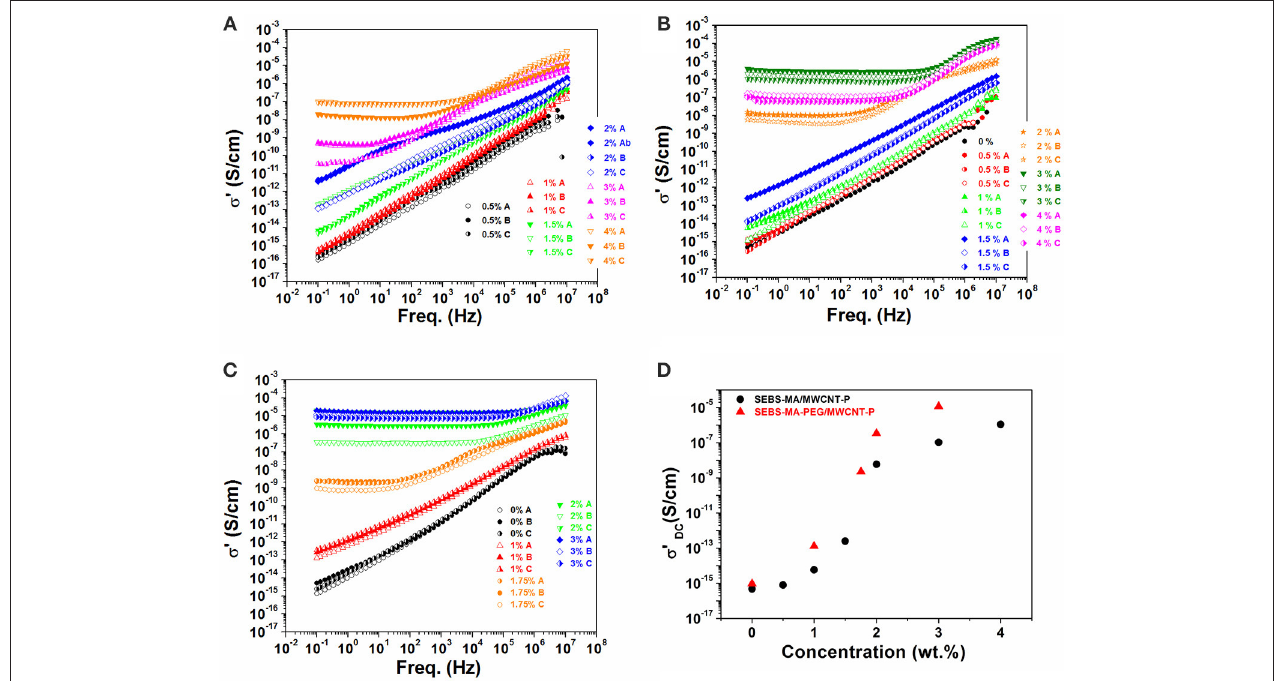
FIGURE 1 | Real part of the complex electrical conductivity vs. frequency measured at various filler loadings of (A) SEBS-MA/MWCNT, (B) SEBS-MA/MWCNT-P, and (C) SEBS-MA-PEG/MWCNT-P composites (three different samples from each MWCNT concentration were measured). In (D) the filler concentration dependence of σ ′ DC for SEBS-MA/MWCNT-P and SEBS-MA-PEG/MWCNT-P composites is